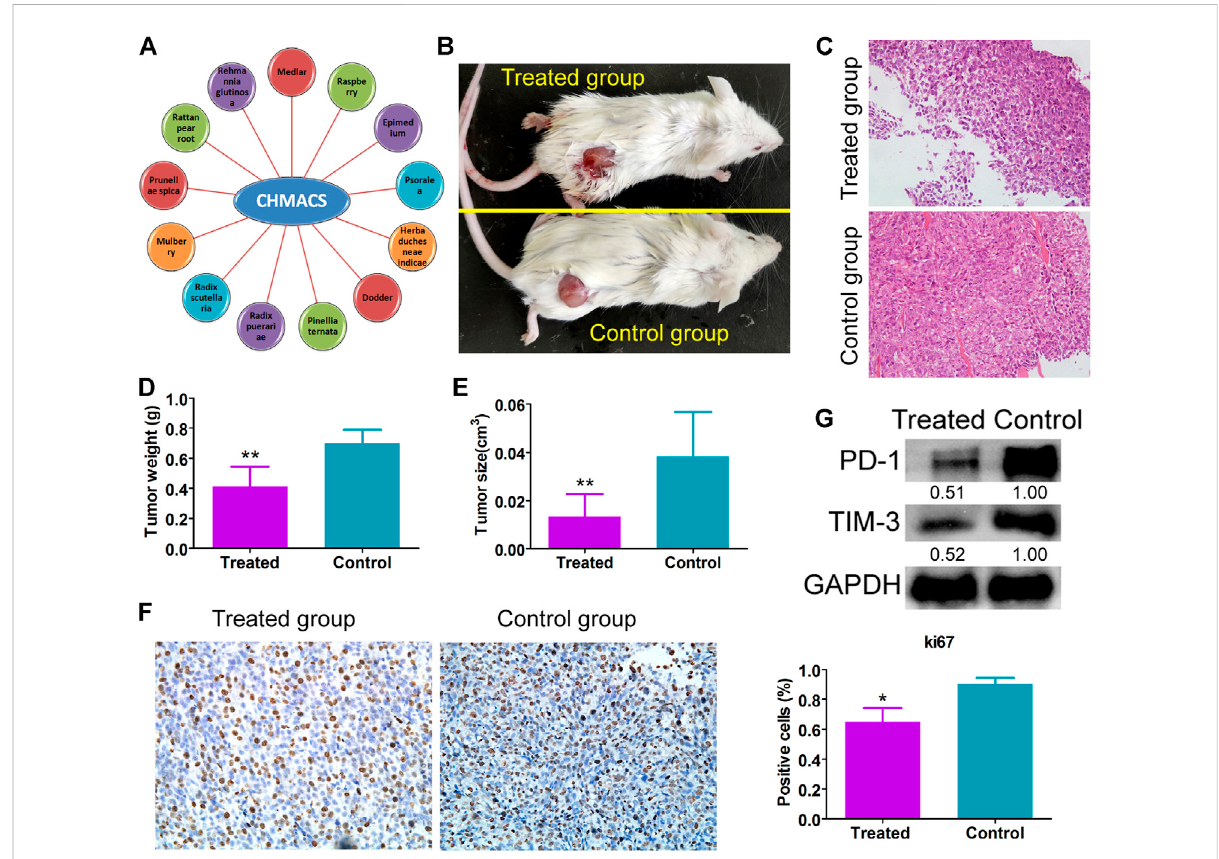
FIGURE 1 CHMACS inhibits the activity of CC cells in vivo (A) Composition of CHMACS. (B) Tumor morphology. (C) Hematoxylin – eosin staining of tumor tissues;** p < 0.01vs.control; n =6; t -test. (D) Tumorweightand (E) volume;** p < 0.01vs.control; n =6; t -test. (F) Immunohistochemicalstainingto assess proportion of cells that were positive for Ki67; * p < 0.05 vs. control; n = 6; t -test. (G) Western blotting